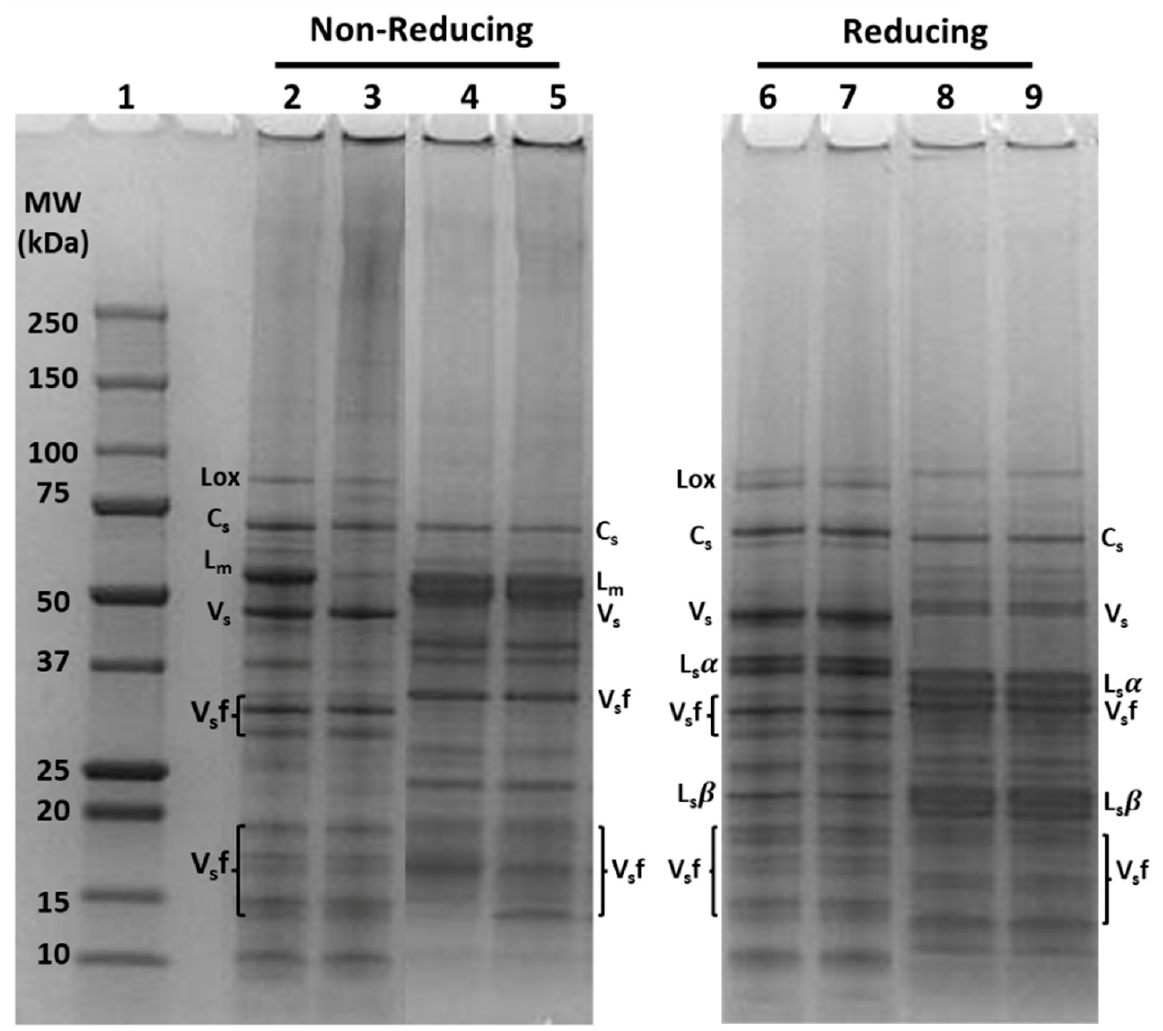
Figure 2. SDS-PAGE gel protein profile visualization of high solid (HS) and low solid (LS) fractions of SU PPI compared to that of cPPI and SU ChPI compared to that of cChPC under non-reducing (lane 2–5) and reducing (lane 6–9) conditions. Lane 1: Molecular weight (MW) marker; Lane 2, 6: SU PPI HS; Lane 3, 7: SU PPI LS; Lane 4, 8: SU ChPI HS; Lane 5, 9: SU ChPI LS. Lox: lipoxygenase; C s : convicilin subunits; L m : legumin monomer; V s : vicilin subunits; L s α : legumin acidic subunits, L s β : legumin basic subunits; V s f: vicilin subunit fractions due to post-translational cleavages. 3.4. Protein Denaturation State of PPI and ChPI as Impacted by Extraction Scale and in Comparison to Commercial Protein Ingredients The impact of the extraction scale (benchtop vs. scale-up) on the protein denaturation (Table 2). Two distinct denaturation temperatures, corresponding to vicilin and legumin, were observed for benchtop and scaled-up PPI and ChPI, in agreement with previous studies [6,15]. Since the endothermic peaks of vicilin and legumin overlapped, as was also observed by others [39,45], both peaks were integrated as one peak and the total enthalpy of denaturation was obtained (Table